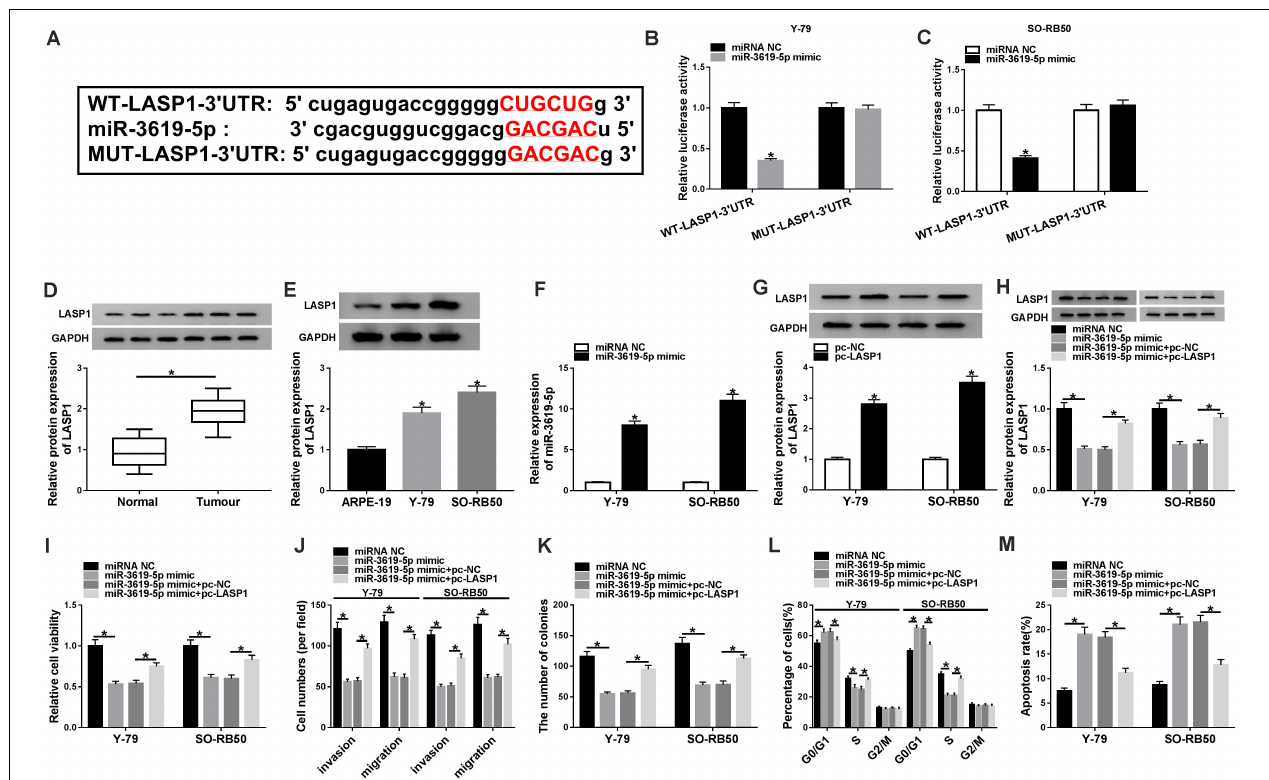
FIGURE 4 | MiR-3619-5p repressed RB cell progression by sponging LASP1. (A) The starBase 3.0 database predicted the binding sites between miR-3619-5p and LASP1. (B,C) The luciferase activities were detected by dual-luciferase reporter assay. (D,E) The protein level of LASP1 was determined by western blot in RB tissue and cells. (F) The transfection efficiency of miR-3619-5p mimic was detected by qRT-PCR. (G) Western blot detected the transfection efficiency of pc-LASP1 in Y-79 and SO-RB50 cells. (H) The impacts between miR-3619-5p mimic and LASP1 overexpression on LASP1 expression were determined by western blot in Y-79 and SO-RB50 cells. (I,K) The cell proliferation was detected by CCK-8 and cell colony formation assays in Y-79 and SO-RB50 cells. (J) The invasive and migratory abilities of RB cells were determined by transwell assay in Y-79 and SO-RB50 cells. (L,M) Flow cytometry analysis revealed that the effects between miR-3619-5p mimic and LASP1 overexpression on the cell cycle and apoptosis of Y-79 and SO-RB50 cells. * P < 0.05.